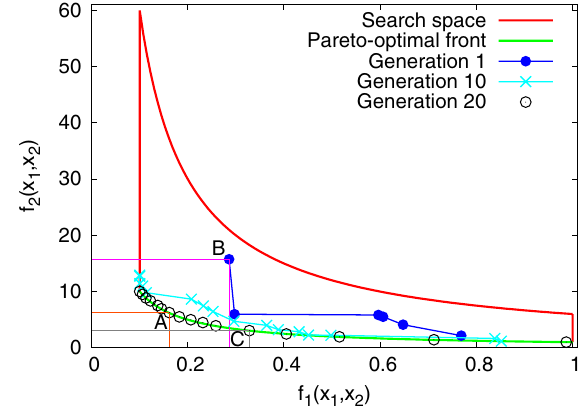
FIG. 1. The search space (red and green) and Pareto-optimal front (green) for the minimization of the system in Eq. (2) [19]. Pareto-optimal front estimates found by the Strength Pareto Evolutionary Algorithm (SPEA2) [20] after 1, 10, and 20 gen- erations for 16 individuals are marked. The overlap between the search space and the rectangles with individuals A , B , and C at the top right vertices contain the points, if any, in the search space that dominate the respective